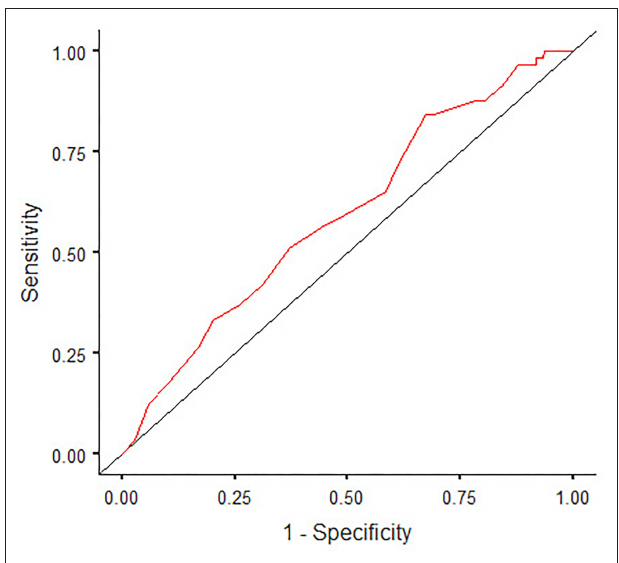
FIGURE 3 | Receiver operating characteristic (ROC) curve logistic regression model for cleft type considering, maternal parity, sex, and geographic origin.